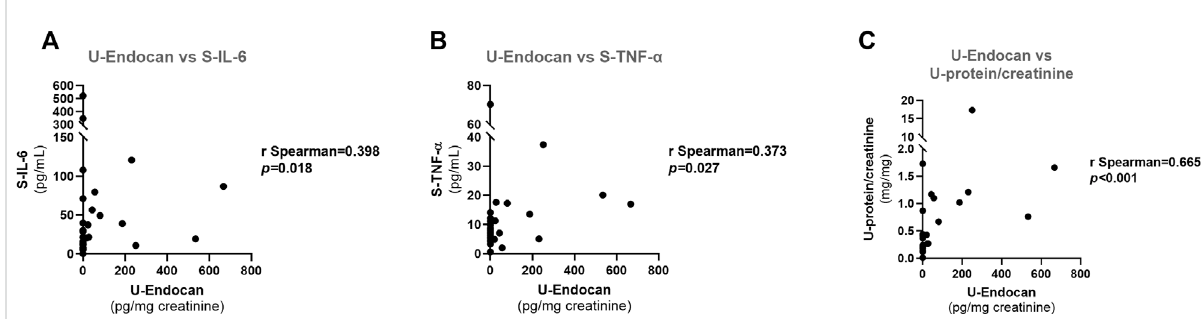
FIGURE 7 Spearmancorrelationsforurinaryendocaninallpatientsatadmission: (A) U-Endocan vs .S-IL-6; (B) U-Endocan vs .S-TNF- α ; (C) U-Endocan vs . U-protein/creatinine.S-IL-6,seruminterleukin6;S-TNF- α ,serumtumournecrosisfactoralpha;U-Endocan,urinaryendocan;U-protein/creatinine, urinary